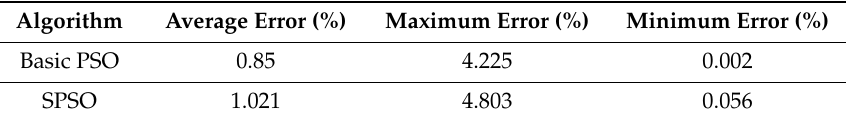
Table 2. The comparison between the basic PSO and SPSO.